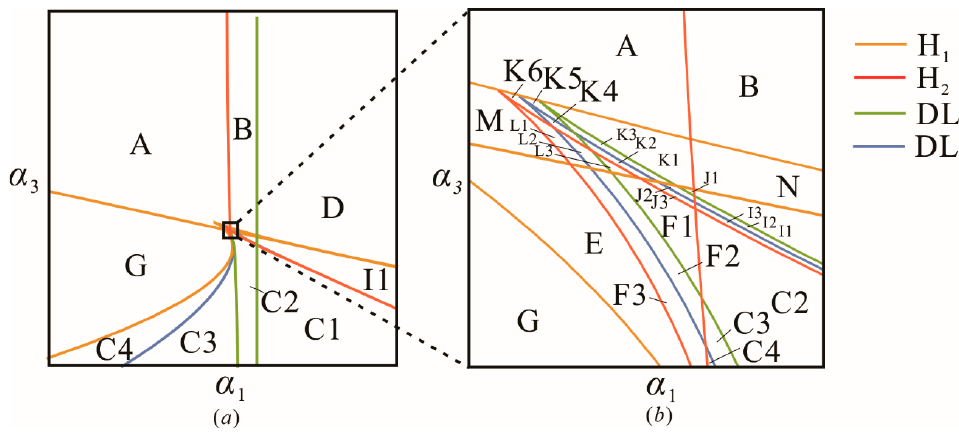
Figure 6. ( a ) α 1 − α 3 plane transition set of the system for primary resonance. ( b ) Partial enlarged view.